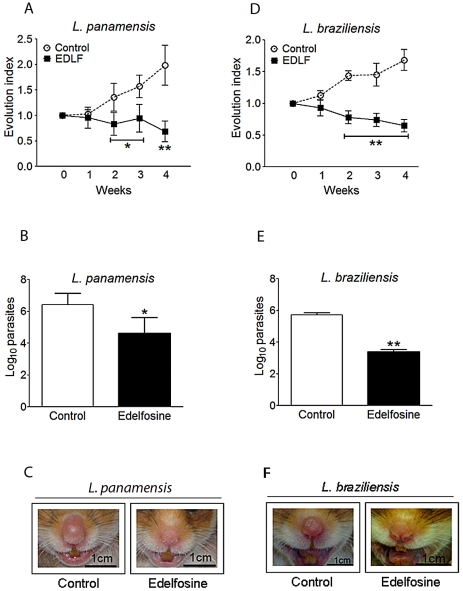

In vivo antileishmanial action of edelfosine in L. panamensis- and L. braziliensis-infected hamsters.Golden hamsters were infected with 1×106
L. panamensis or L. braziliensis promastigotes in the nose, and after swelling was perceptible, hamsters were randomized into drug-treated (26 mg edelfosine/kg of body weight, daily oral administration for 28 days) and control (water vehicle) groups of 7 hamsters each. (A, D) Lesion development was monitored by measuring nose thickness at regular intervals, and comparison to values obtained before treatment (evolution index). (B, E) Parasite load was determined by limiting dilution assays after completion of the 4-week in vivo assays. Data are means ± SD (n = 7). Asterisks indicate that the differences between control and edelfosine-treated groups are statistically significant. (*) P<0.05. (**) P<0.01. (C, F) Edelfosine treatment led to a dramatic decrease and amelioration in parasite-induced nose thickness and damage, as shown by representative photographs from drug-free control and edelfosine-treated hamsters.